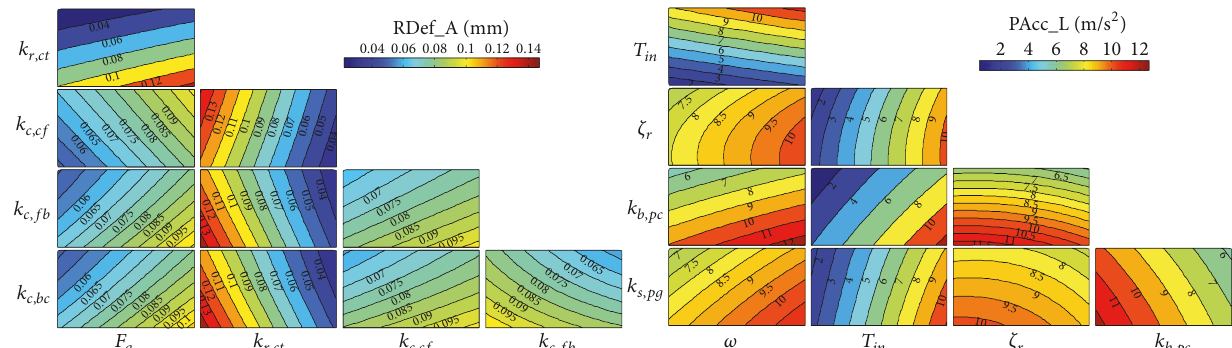
Figure 12: Variation of the axial vibration displacement (RDef A) and lateral acceleration (PAcc L) with respect to the parameters with the greater